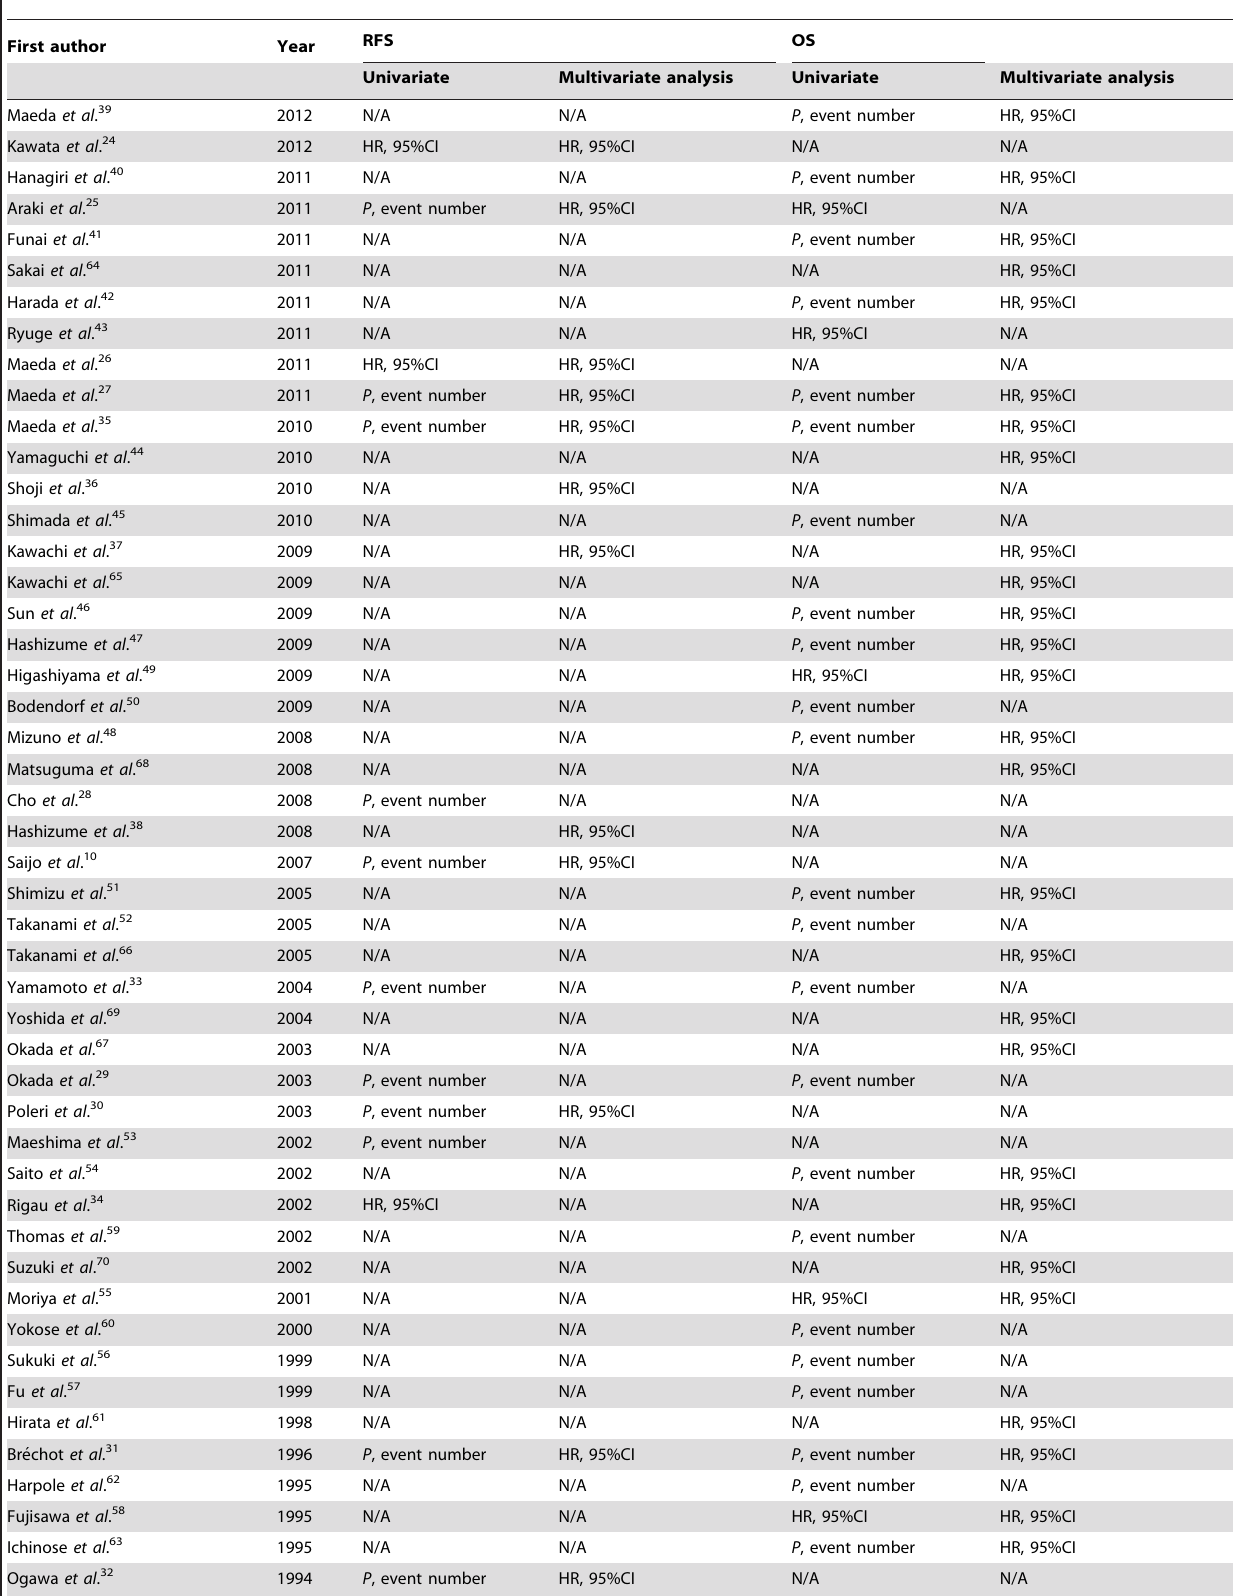
Table 1. Data source for the estimating of HR form included studies evaluating LVI and